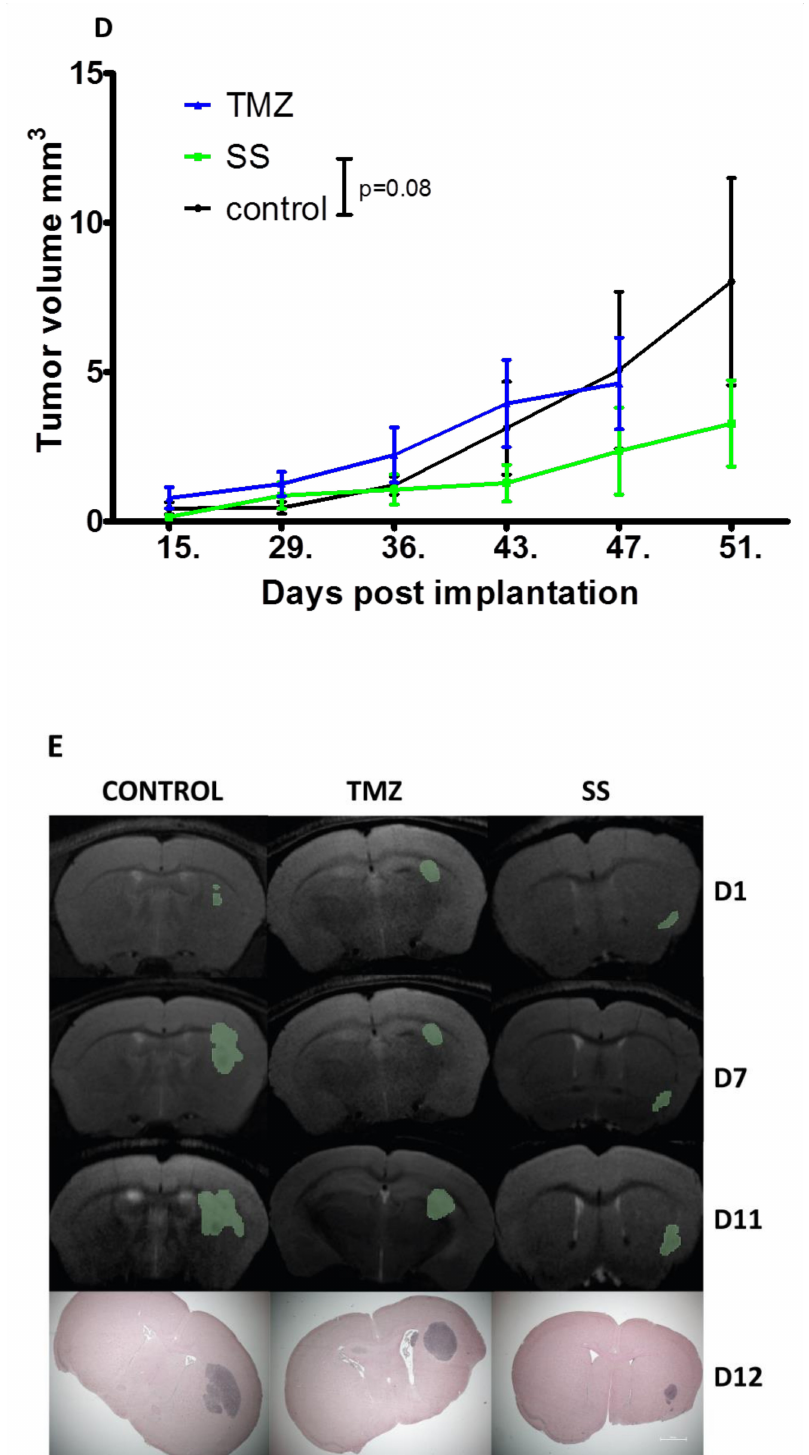
Figure 4. ( A ) Immunocytochemical staining for CD34, CD44, CD56, GFAP, nestin, and Olig2 expression in R2J-GS cells in culture just before their implantation into the striatum, and in the control mice group (placebo-receiving group), SS group, and TMZ group. Scale bar = 100 µ M; objective X20. Evaluation of ( B ) Se in plasma and in the brain, kidneys, liver, and lungs, and ( C ) GPX activity in mice receiving SS and TMZ orally compared to the control group. ( D ) Mice were implanted with 1000 R2J-GS cells, were divided into three groups (control, SS receiving 6.75 mg/kg, and TMZ receiving 5 mg/kg), and the progression of the tumors was followed by MRI 15, 30, 37, 41, 47, and 51 days post-implantation. Tumor volume was calculated using 3D Slicer software, and comparisons were performed between the control vs. SS and control vs. TMZ